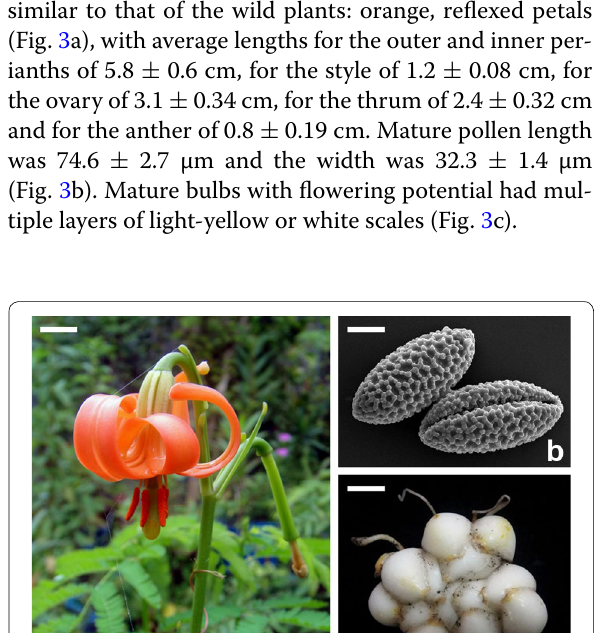
24). (Bar 5 μm). b Karyogram. Arrow indicates the = =